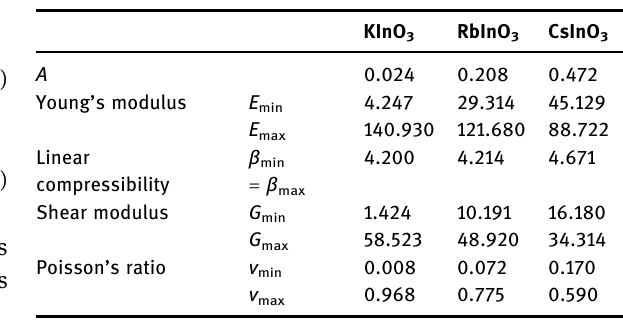
Table 3: The calculated Zener ratio ( A ) and max – min points